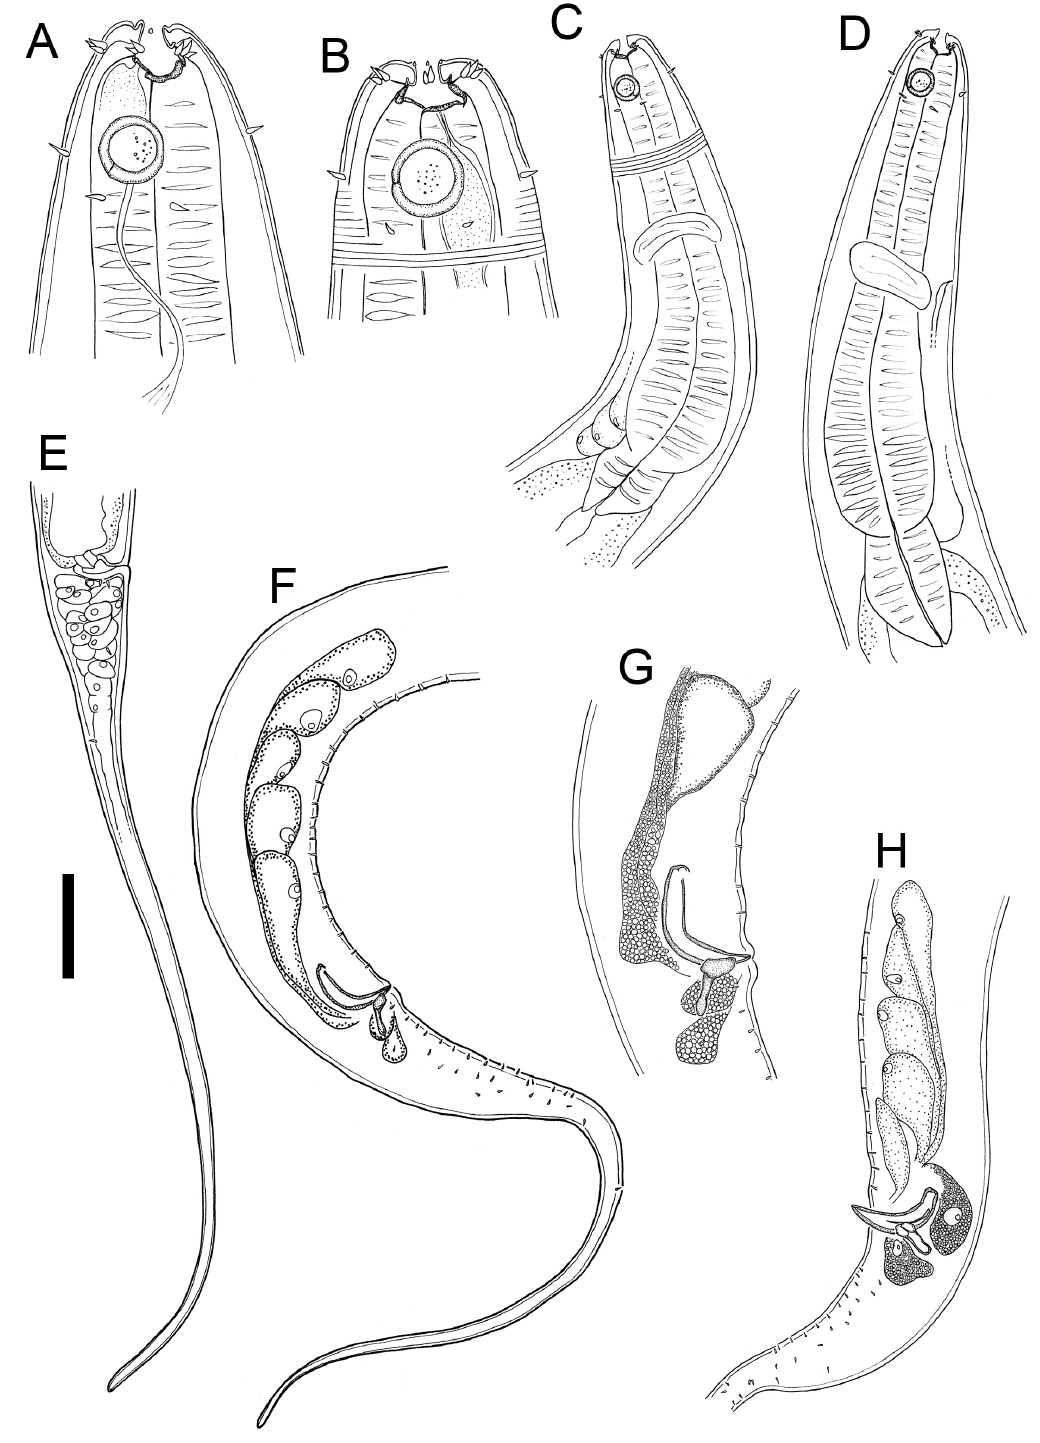
Fig. 4. Linhomoeus pycnocricus sp. nov. A , D . Paratype (NIWA154910). B , F – G . Paratype (NIWA154907). C , H . Paratype (NIWA154908). E . Paratype (NIWA154909). A . Female cephalic region. B . Male cephalic region. C . Male anterior body region. D . Female anterior body region. E . Female posterior body region. F . Male posterior body region. G . Copulatory apparatus. H . Copulatory apparatus and ejaculatory glands. Scale bar: A–B = 25 µm; C–D = 75 µm; E = 85 µm; F = 80 µm; G = 50 µm; H = 70